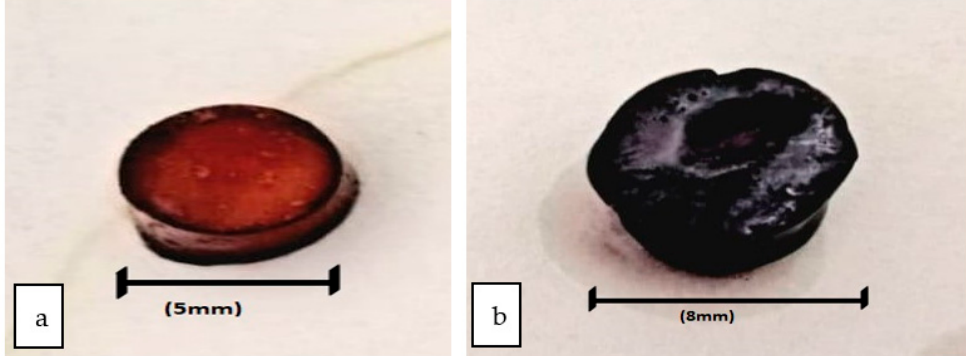
Figure 2. Formulation (F3) Esomeprazole-loaded hydrogel ( a ) Before swelling ( b ) After swelling.